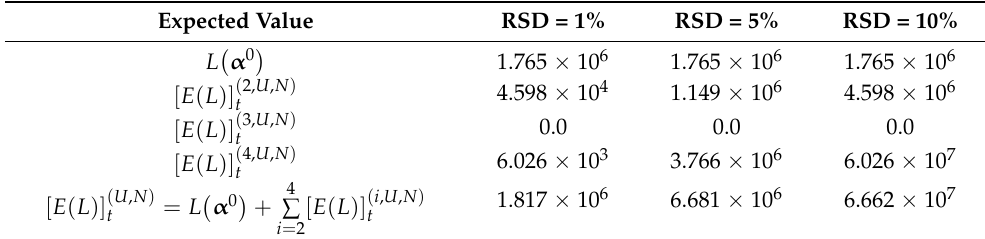
Table 1. Comparison of Expected Values for Various Relative Standard Deviations (RSD) of the Normally-Distributed and Uncorrelated Microscopic Total Cross